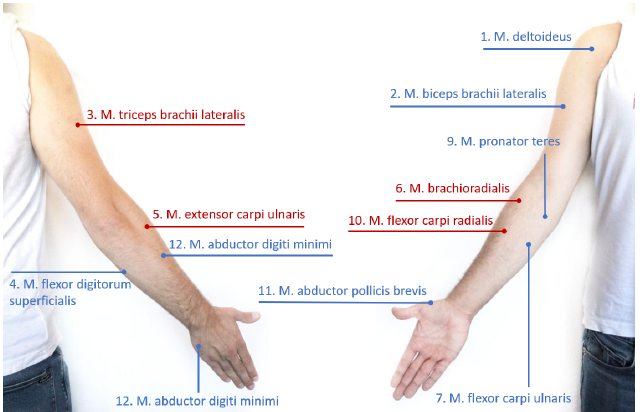
Figure 2. EMG sensor placement in accordance with SENIAM recommendations (back and front views of the right arm). In blue, the muscles used as measures in the MVE algorithm; in red, the estimated